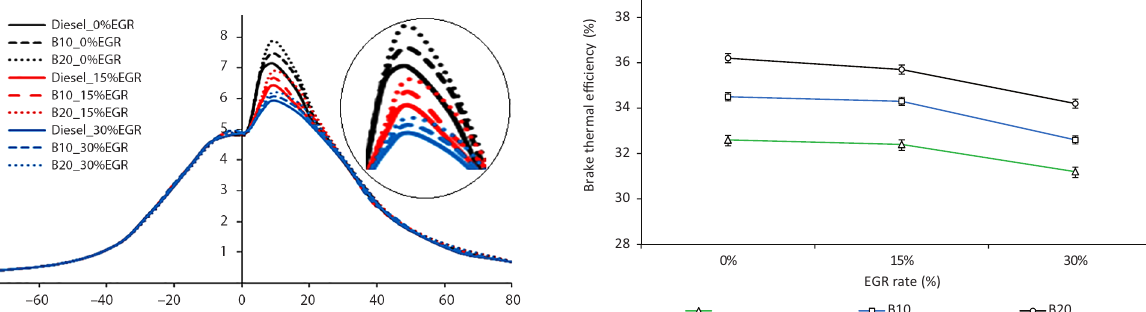
Figure 3. Effect of alcohol blends and different EGR rates on BTE under 1800